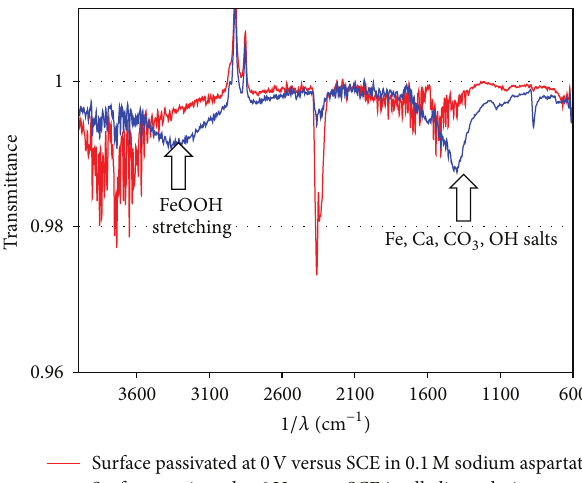
Surface passivated at 0V versus SCE in 0.1M sodium aspartate Surface passivated at 0V versus SCE in alkaline Figure 14: FTIR spectra of a specimen passivated in solution with and without sodium aspartate 0.1M at pH 13.4 and 0V versus SCE.